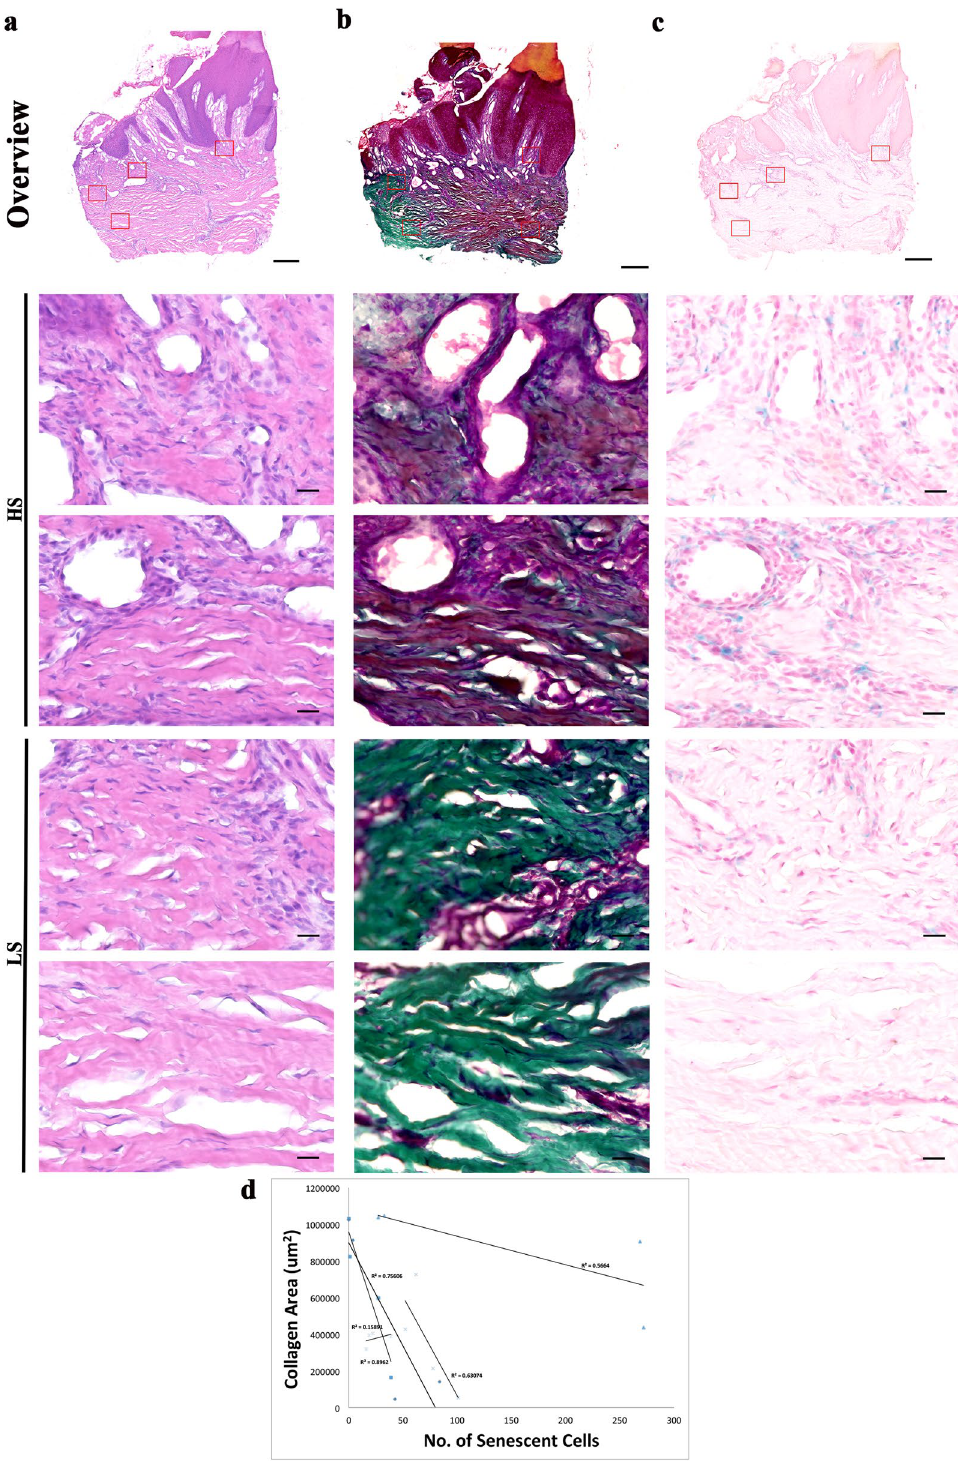
Figure 2. Staining of nuclei, collagen and senescent cells of diabetic foot ulcer biopsies revealed a strong link between presence of senescent cells and collagen area. ( a ) Haematoxylin and eosin staining of nuclei (purple) and extracellular matrix proteins (pink) in a diabetic foot ulcer. Montage of high-power images [1200 (W) × 1000 (H) μm] of an 8 μM thick cryosections—two from high senescence (HS) regions and two from low senescence (LS) regions of a diabetic foot ulcer taken using × 20 objective lens. ( b ) MT staining collagen (green), muscle and keratin (red) and cytoplasm (pink/red) in a sister section. Montage followed by ( c ) X-gal staining as a marker for senescent cells (senescent cells (blue), nuclei and cytoplasm (pink). Scale bars, montage 500 μm and high power 20 μm. ( d ) Regression plots of collagen area (x-axis) against senescent cell number (y-axis) of individual patient of the DFU